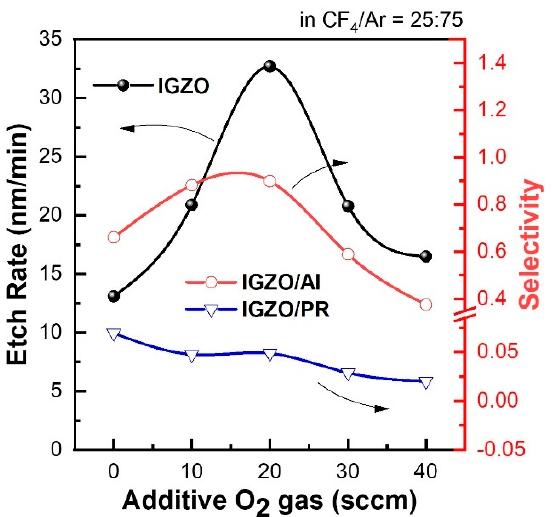
Figure 1. Etch rate of IGZO thin films and etch selectivity to Al and PR as a function of additive O 2 gas flow rate with fixed CF 4 /Ar = 25:75 sccm. (500 W source power, 100 W bias power, and 15 mTorr pressure).